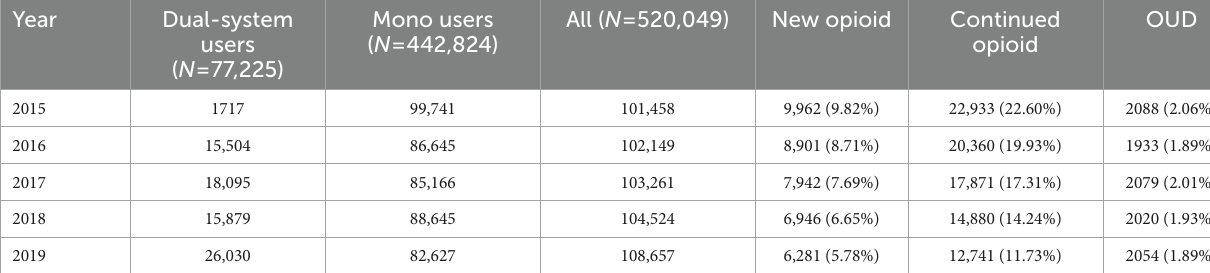
TABLE 1 Number of dual-system and mono users by year.